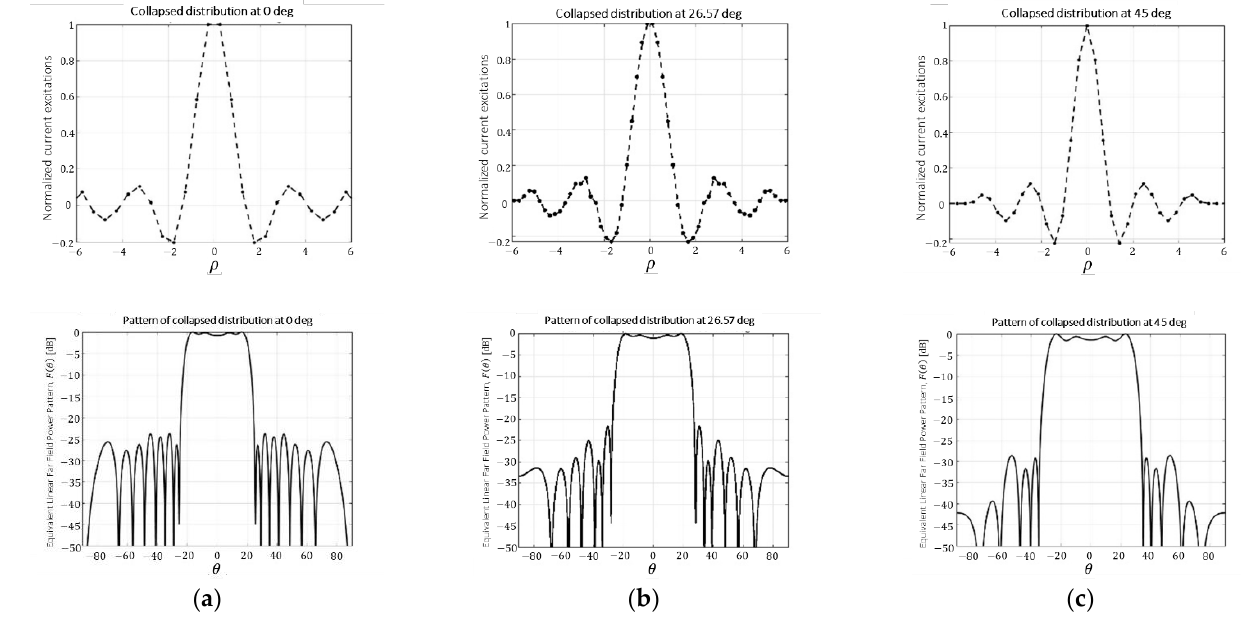
Figure 8. Aperture distributions and far field patterns of different collapsed cuts of the planar array whose three-dimensional pattern is reported in Figure 6: ( a ) 0 ◦ ; ( b ) 26.57 ◦ ; ( c ) 45 ◦ . These figures illustrate the effective size of the antenna on each one of the cuts.